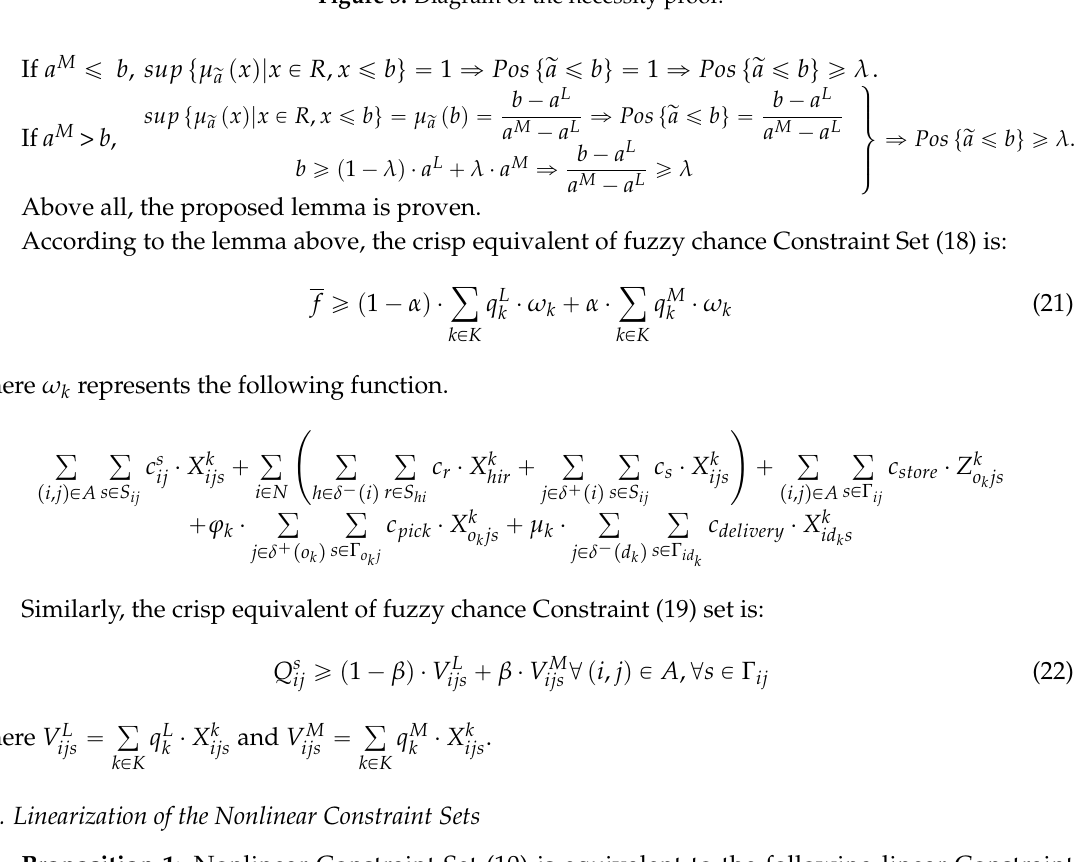
Figure 3. Diagram of the necessity proof.